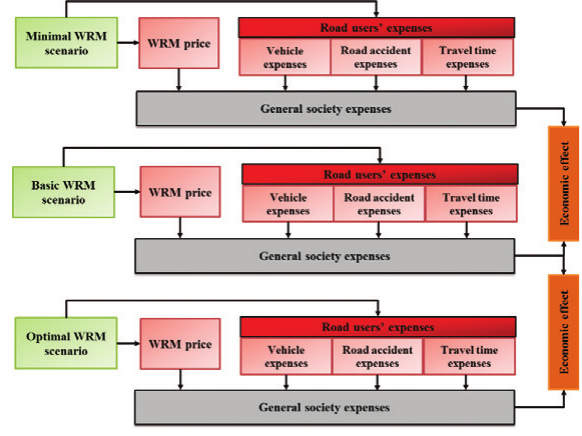
Fig. 6. The scheme of winter road maintenance levels